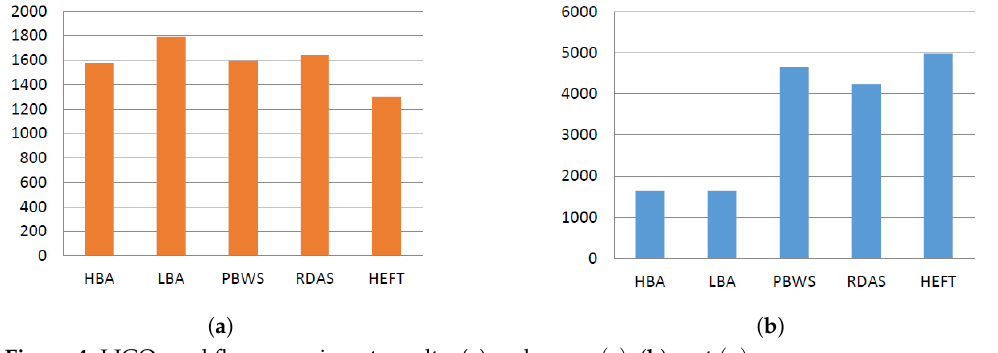
Figure 4. LIGO workflow experiment results. ( a ) makespan ( s ) ; ( b ) cost (  ) .